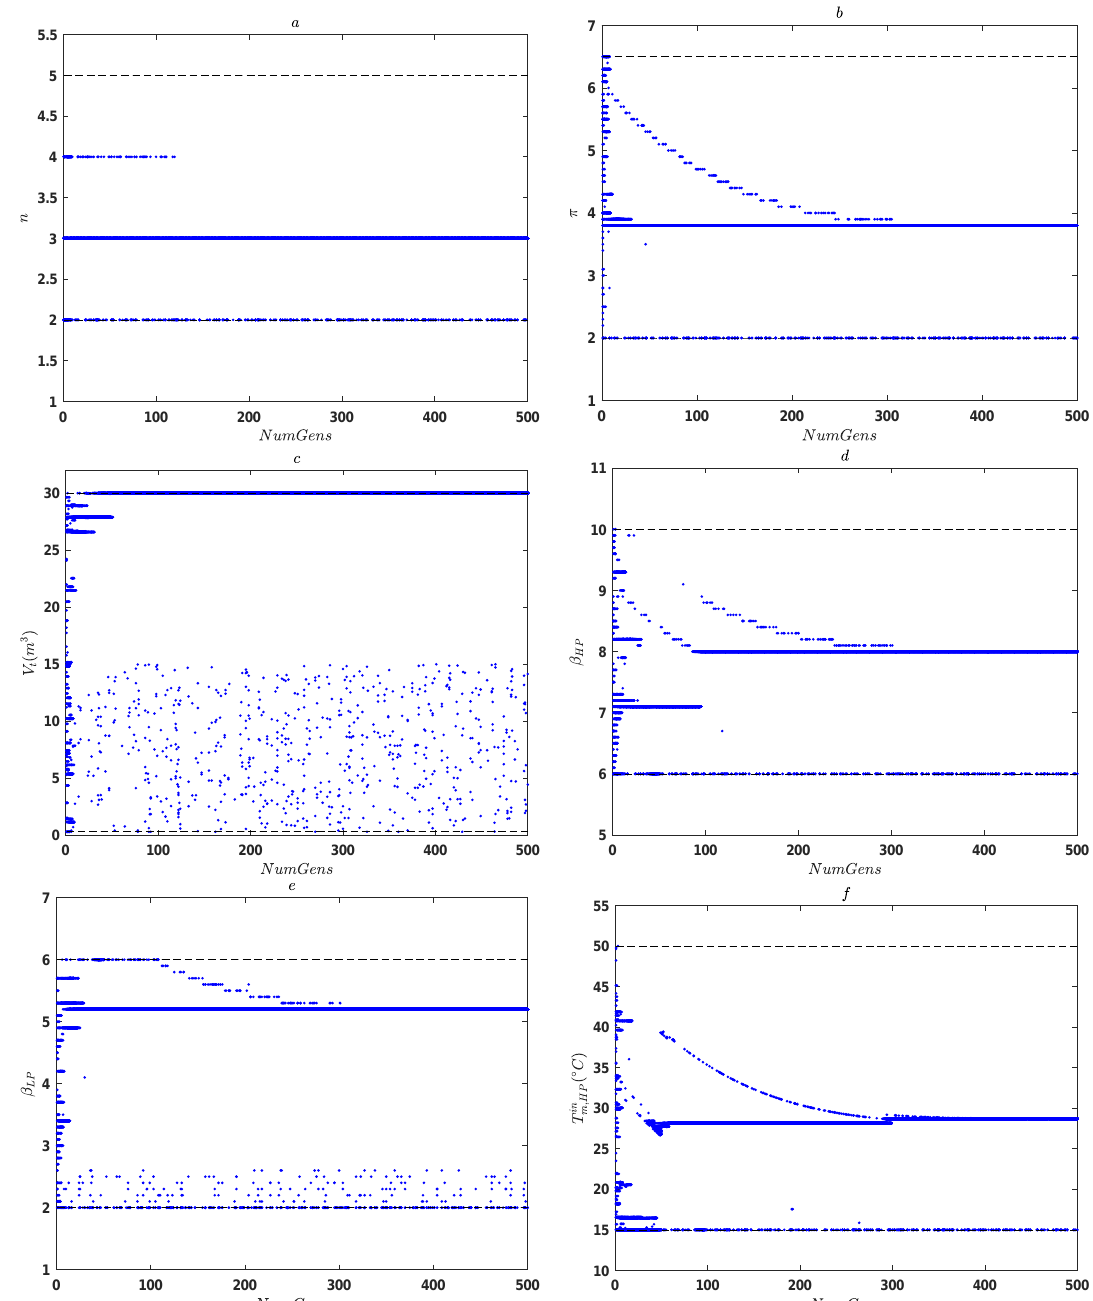
Figure 8. Scattering of optimal design variables during evolution; the case of the number of compression stage ( a ), of the compression pressure ratio ( b ), of the volume of air storage tank ( c ), of the pressure ratio of the high-pressure expansion stage ( d ), of the pressure ratio of the low-pressure expansion stage ( e ) and of the inlet temperature of the high-pressure expansion stage ( f